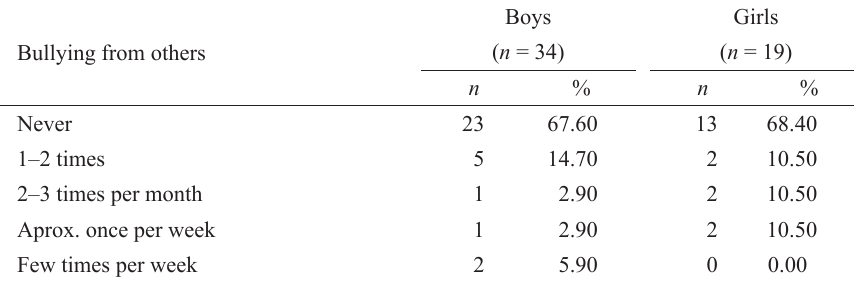
The experience of bullying from others during the past few months Bullying from